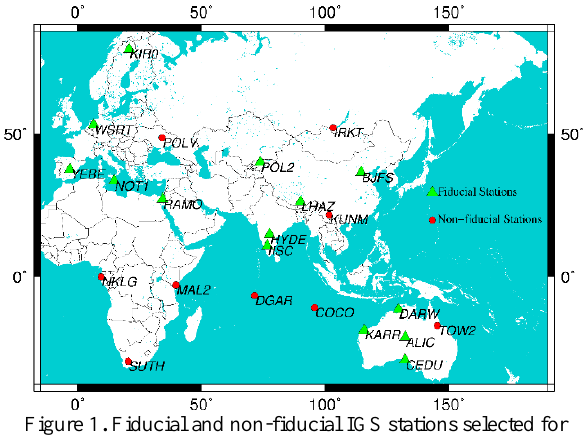
Figure 1 . Fiducial and non-fiducial IGS stations selected for